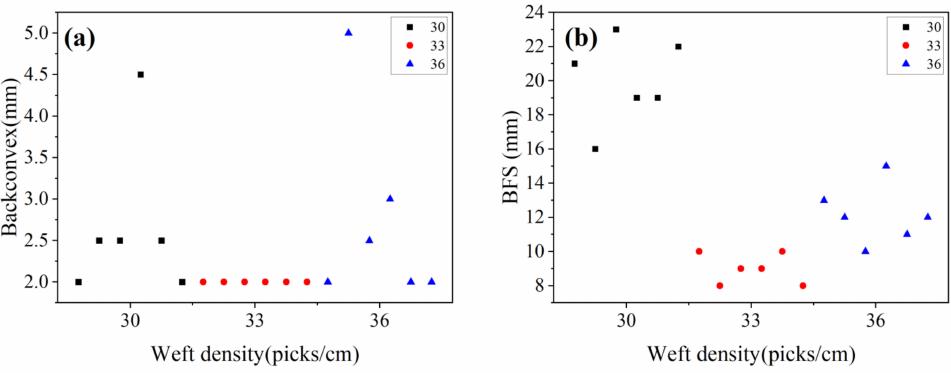
Figure 14. The back convexity and BFS of three kinds of weft densities: ( a ) Back convexity; ( b ) BFS. The back convexity and BFS of the three different weft density objectives are displayed in Figure 15. Cross-sectional views of armor materials with three weft density requirements in the 0 ◦ firing direction are presented in Figure 16.